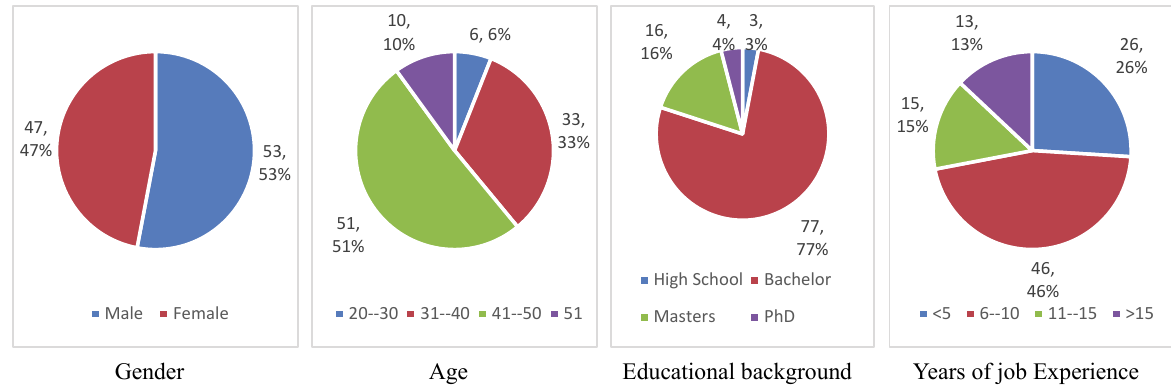
Fig. 2. Personal characteristics of the